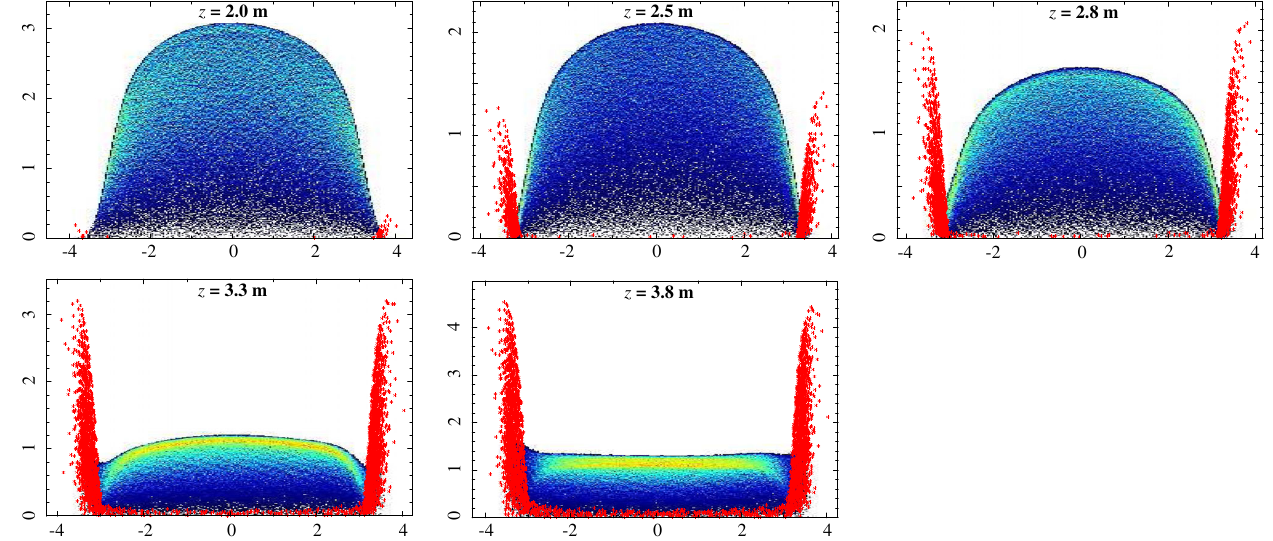
FIG. 16. Particle distribution (radius versus longitudinal position ζ in millimeters) in the vicinity of the beam size focus at z ¼ 2 . 0 , 2.5, 2.8, 3.3, and 3.8 m. Particles which have been detected as overfocused — plotted as red stars on top of a density map of the not overfocused particles — spill out in the head and tail of the bunch. In total, 1.8% of the particles are declared as